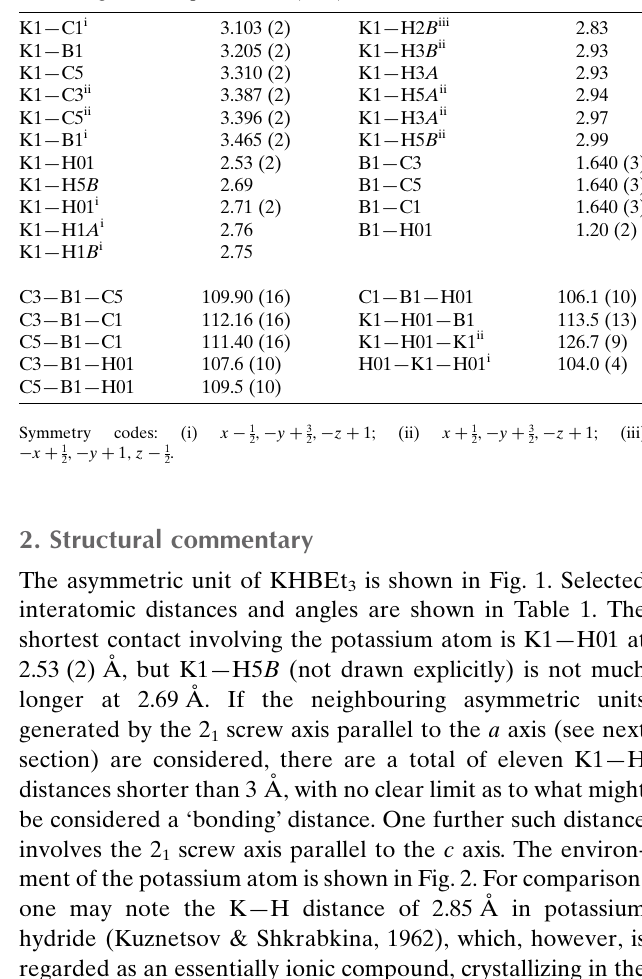
(cid:3) y , + x , 3 2 2